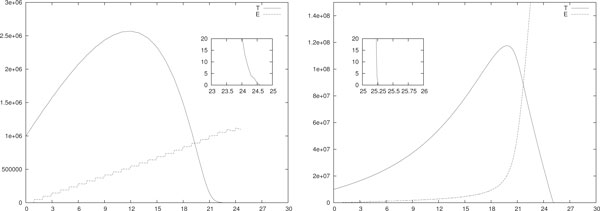
Single run, ACI mono-therapy and larger tumor. Single-run of impulsive daily ACI with T(0) = 106 (left) and T(0) = 107 (right). In both cases E(0) = I(0) = 0. In (left) wi = 5 · 104 for i = 1, . . . , 30. In (right) wi = 20 · 105 for i = 1, . . . , 30. All the other parameters are as in Table 3.